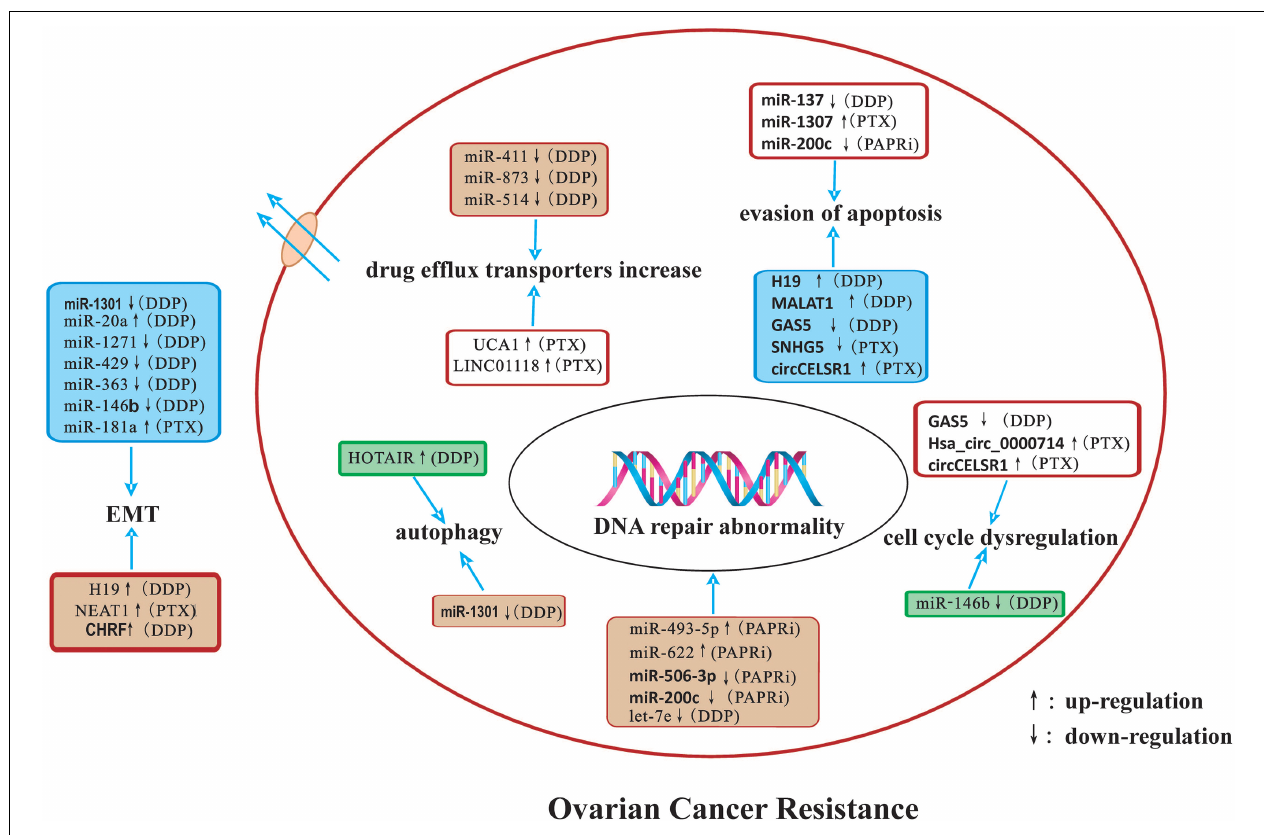
FIGURE 1 | A summary diagram of miRNAs, lncRNAs, and circRNAs involved in the drug resistance of ovarian cancer. Several ncRNAs could participate in drug resistance of ovarian cancer by influencing cell apoptosis, proliferation, cell cycle, autophagy, DNA repair, and epithelial-mesenchymal transition through modulating the expression of downstream target genes and related signaling